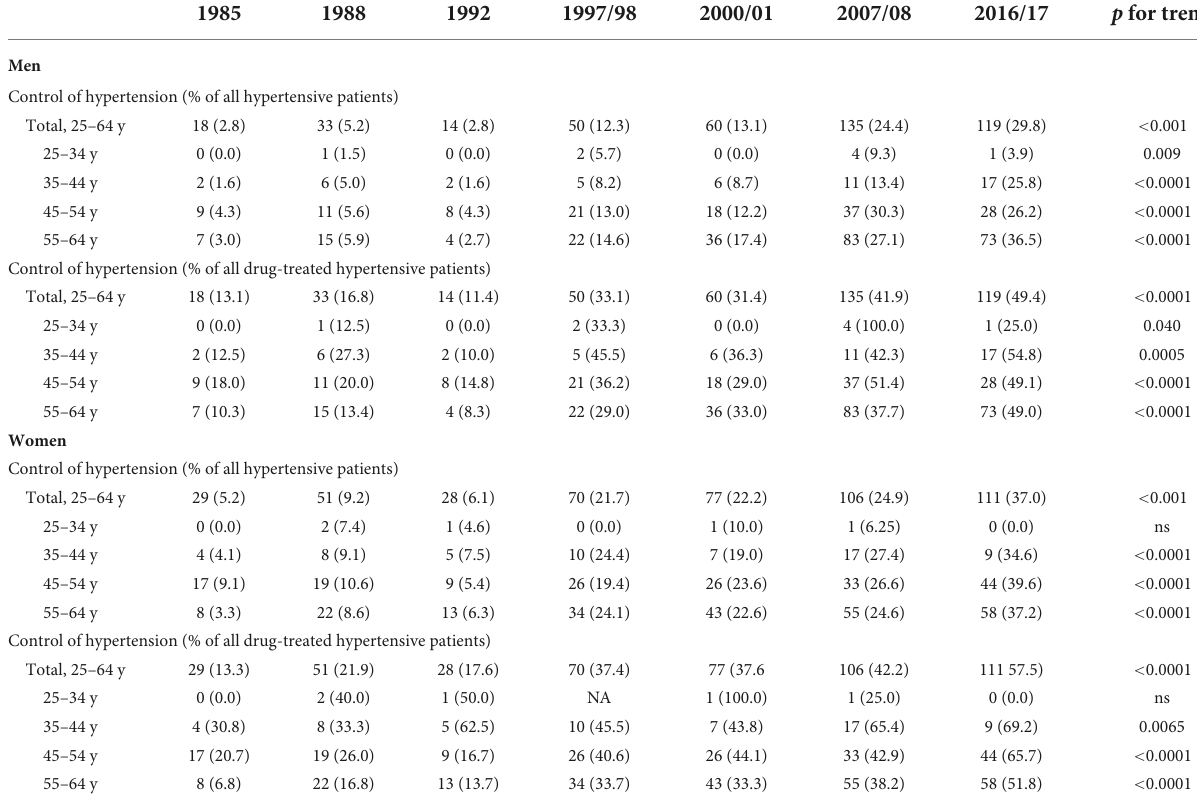
TABLE 4 Control of hypertension between 1985 and 2016/17 in six districts of the